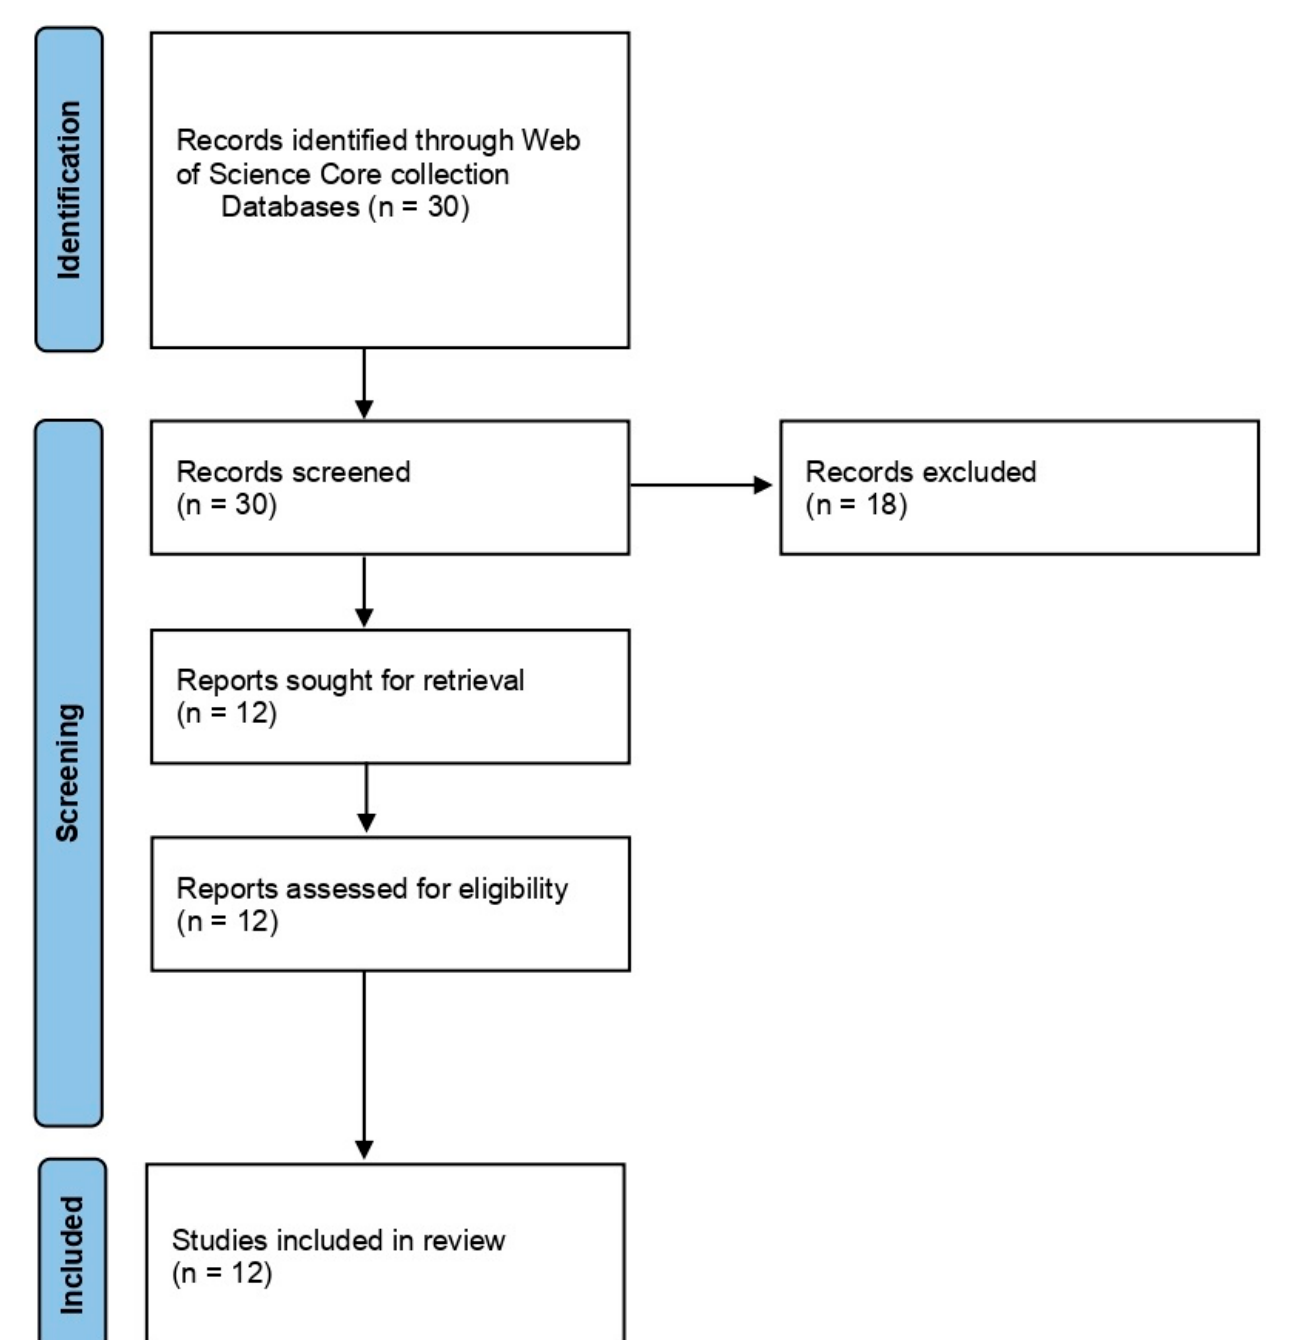
Figure 2. PRISMA flowchart summarizing the information gathering sequence and selection for the systematic review of Group 1: Effect of NTP/Cold plasma on inactivation of Fusarium spp. In the case of Group 2, Effect of NTP/cold plasma on degradation/decontamination of DON mycotoxin, we searched the Web of Science core collection database by using the terms ‘cold plasma’ AND ‘Fusarium’ AND ‘deoxynivalenol’. The search returned with nine articles of which we excluded the three review articles. The remaining six articles were considered and used for the systematic review. The articles were selected and reviewed following PRISMA statement guidelines (Page et al., 2021) [74] (Figure